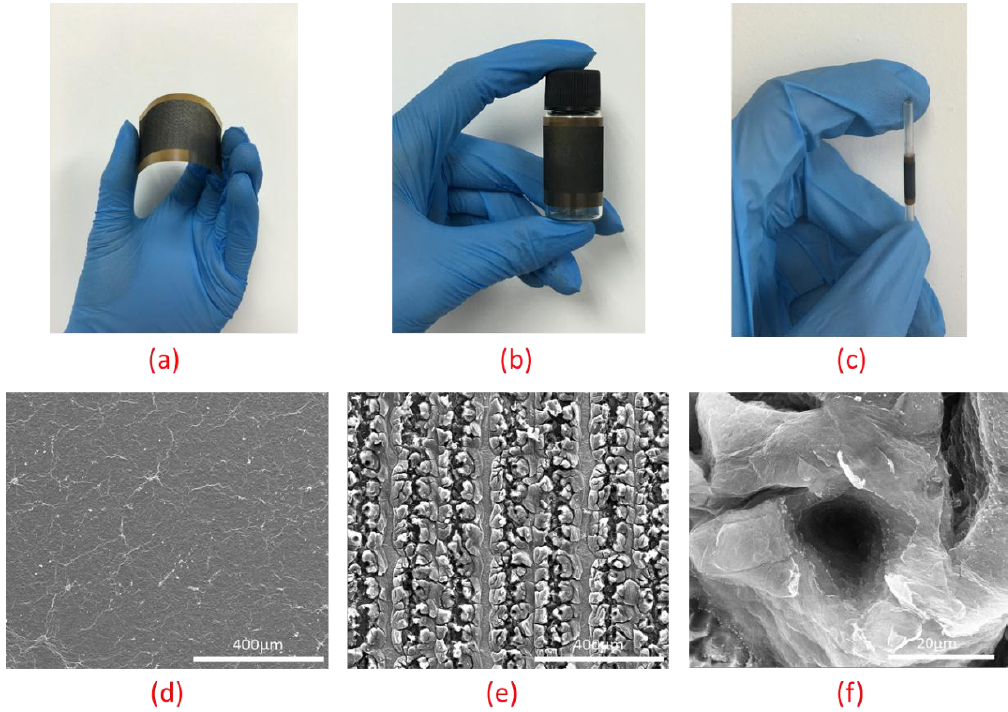
Figure 3. The morphology and structure of the laser induced graphene thermal sound source. ( a ) The flexible thermal sound source in hand. ( b ) The 360-degree thermal sound source attached to a cylindrical bottle. ( c ) The 360-degree thermal sound source attached to an ultrathin stick. ( d ) The surface profile of graphene oxide (GO) under scanning electron microscope (SEM). ( e ) The SEM image of laser induced graphene under low magnification. ( f ) The SEM image of laser induced graphene under high magnification.